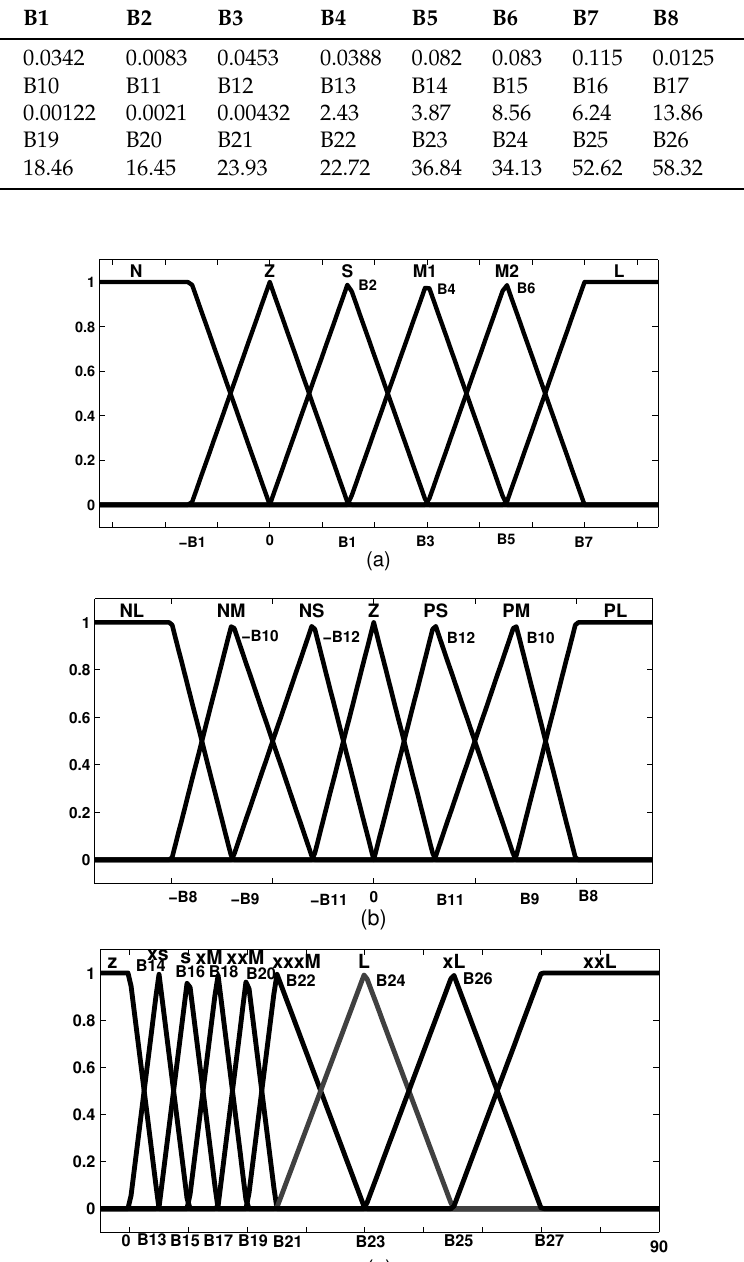
Figure 6. ( a ) Fuzzy membership functions for the pitch angle controller’s first input. ( b ) Fuzzy membership functions for the pitch angle controller’s second input. ( c ) Fuzzy membership functions for the pitch angle controller’s